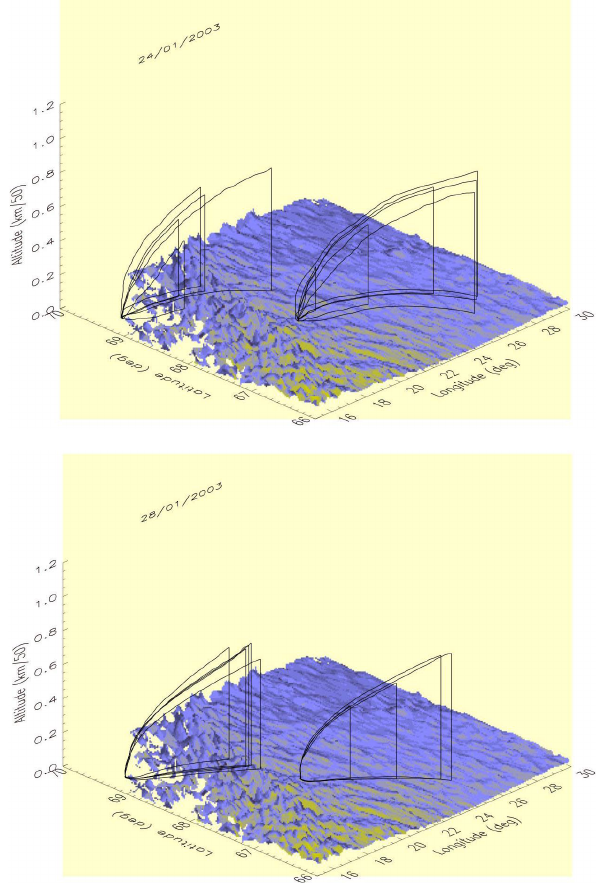
Fig. 6. 3-D flight trajectories of the radiosonde balloons launched during winter for 24 January (top) and 28 January 2003 (bottom) flight sequences. Scales are longitude, latitude and altitude, where altitude refers to the trajectory. The vertical scale of the terrain has been expanded to make it visible on the plot. Balloon tracks from both Andøya and Esrange are shown. Of note are the nearly identi- cal patterns from each site, demonstrating the large-scale uniformity of the winds